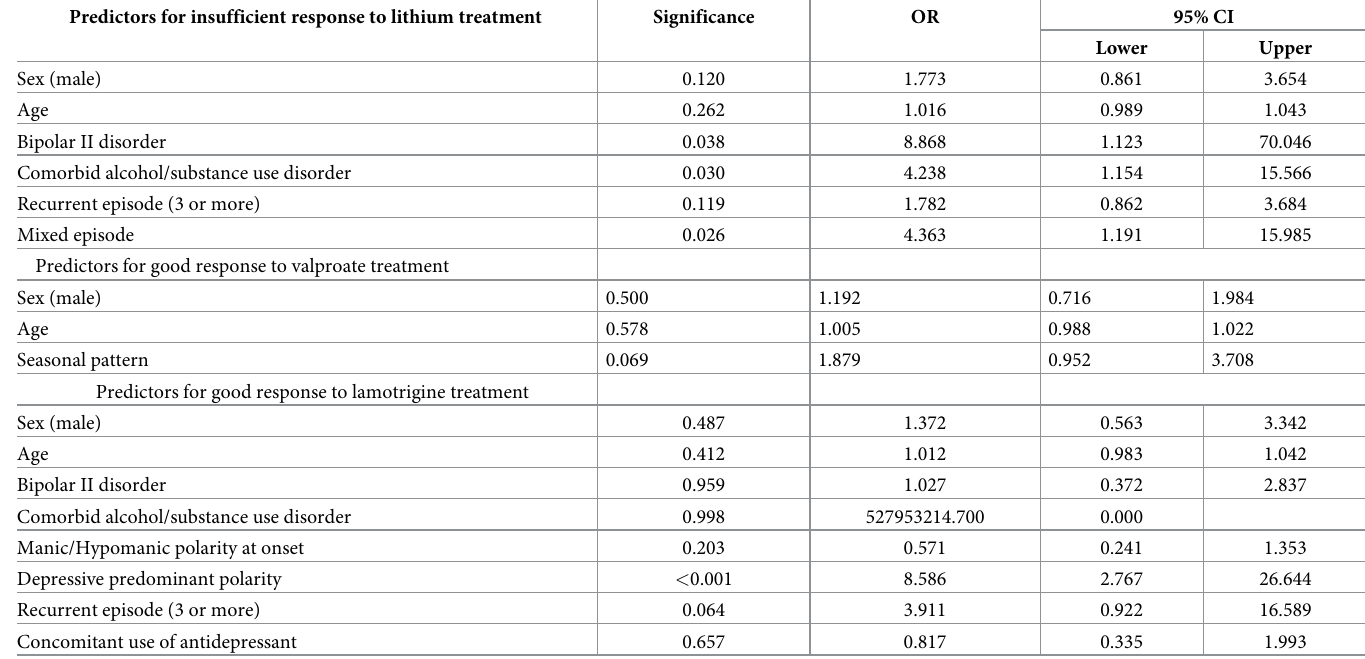
Table 4. Models of multivariate logistic